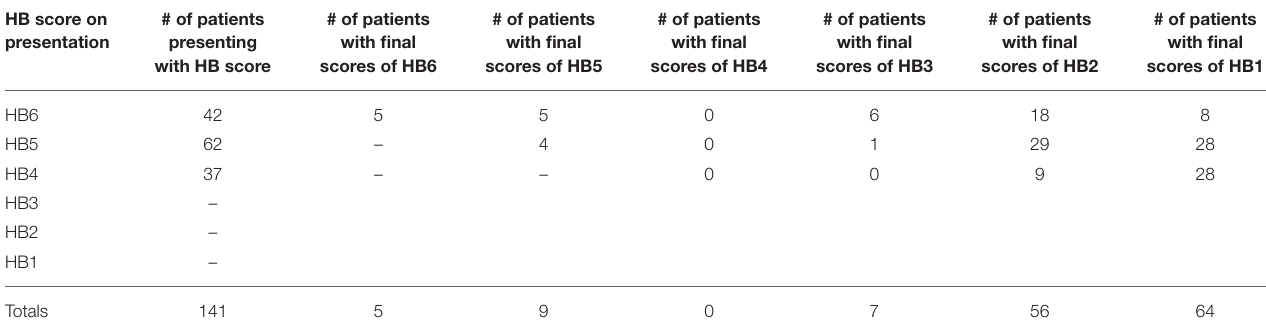
TABLE 2 | Post-operative HB scores, tabulated by HB score on presentation. HB score on presentation